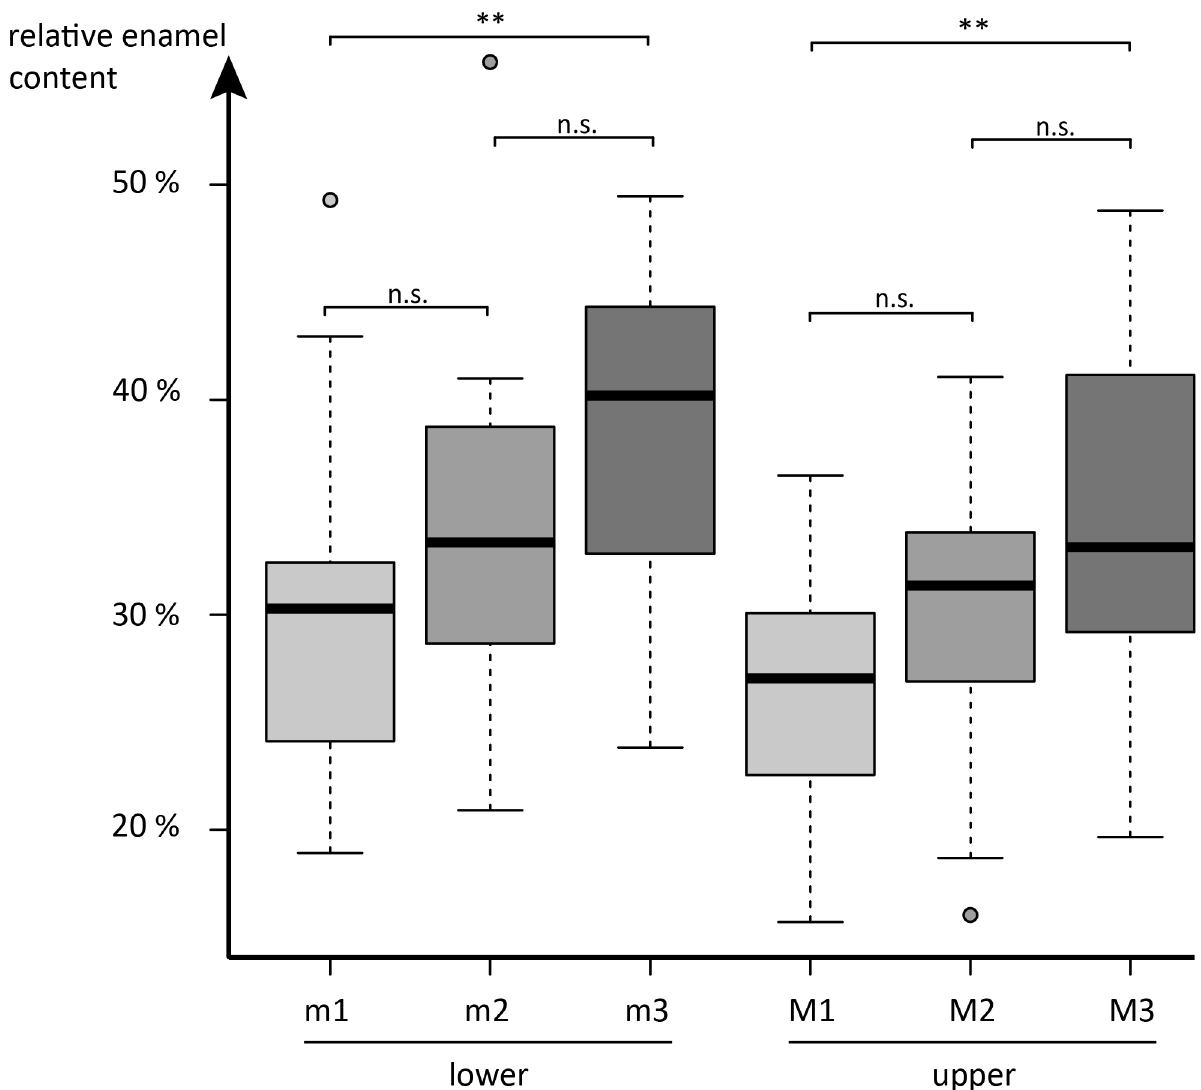
Fig 1. Boxplots of overall relative enamel content per tooth position. * : p = 0.05, *** : p = 0.001, n.s. = not significant (all p-values from post-hoc Tukey test).